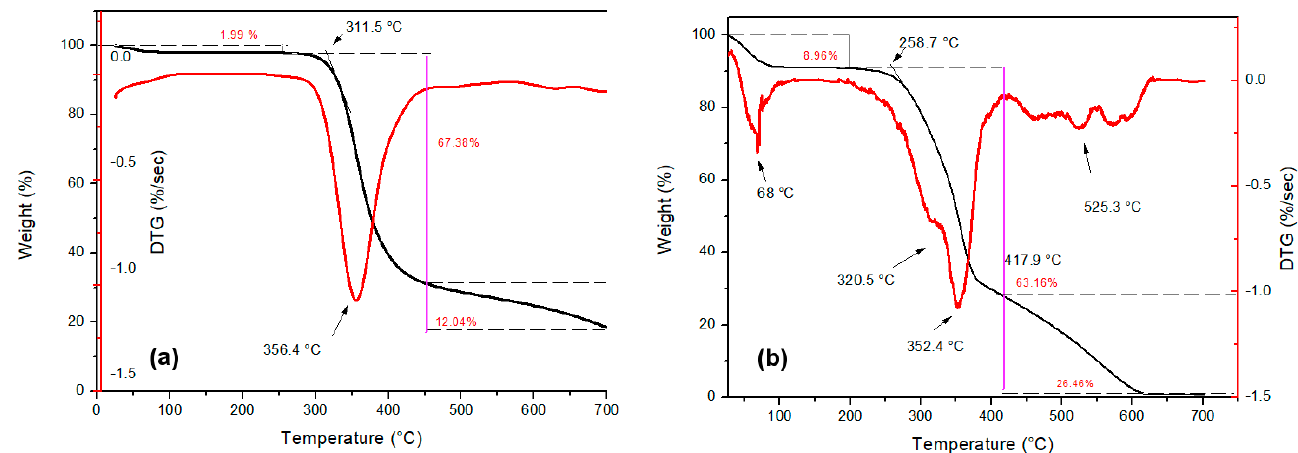
Figure 3. TG and DTG curves for ( a ) epoxy resin; ( b ) untreated